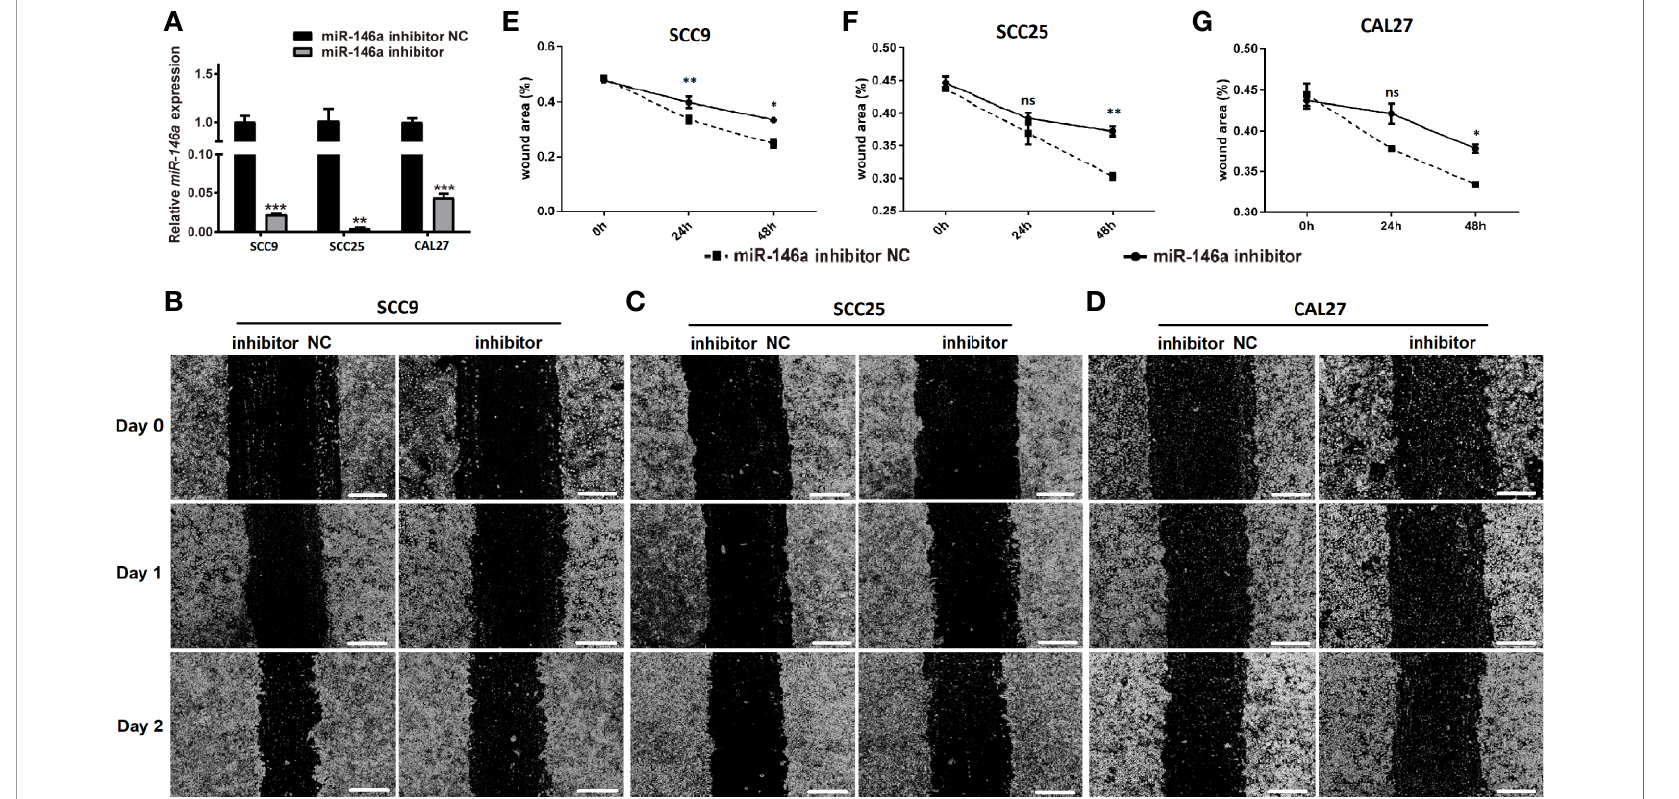
FIGURE 3 | The knockdown of miR-146a inhibited the OSCC cell migration in scratch wound assay. (A) Relative expression of miR-146a in OSCC cells transfected with miR-146a inhibitor or miR-146a negative control. Representative microscopic images scratch wound assay in (B) SCC9, (C) SCC25, and (D) CAL27 cells. In the scratch wound assay, quantitative analysis was performed on migrating cells at 0, 24, and 48, (E) SCC9, (F) SCC25, and (G) CAL27 cells. Data are presented as mean ± SD form three independent experiments in triplicate. Signi fi cant effect of the miR-146a inhibitor treatment, *P < 0.05, **P < 0.01, and ***P < 0.001. NC, negative control. Scale bar, 100 m